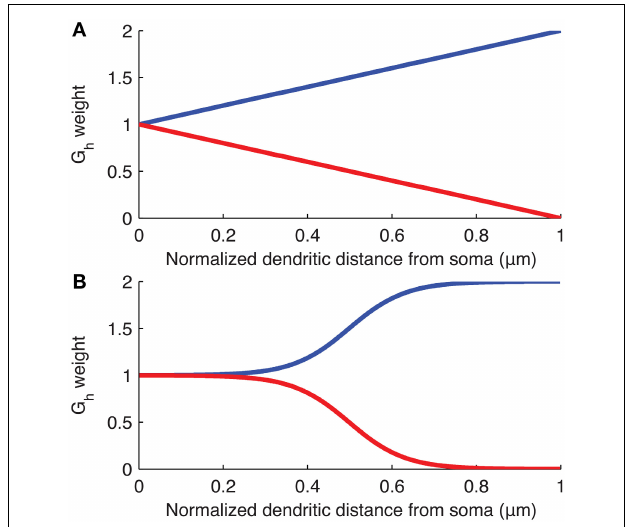
FIGURE 2 | Weighting of G h as a function of distance along dendrites from soma. Plots of the equations specifying the (A) linear and (B) sigmoidal distributions of G h along the dendrites of the models used. The curves show linear or sigmoidal increase or decrease of G h based on the dendritic scaling factor, k d , where k d of 1 and − 1 are plotted as, respectively, blue and red curves, in both (A,B) .